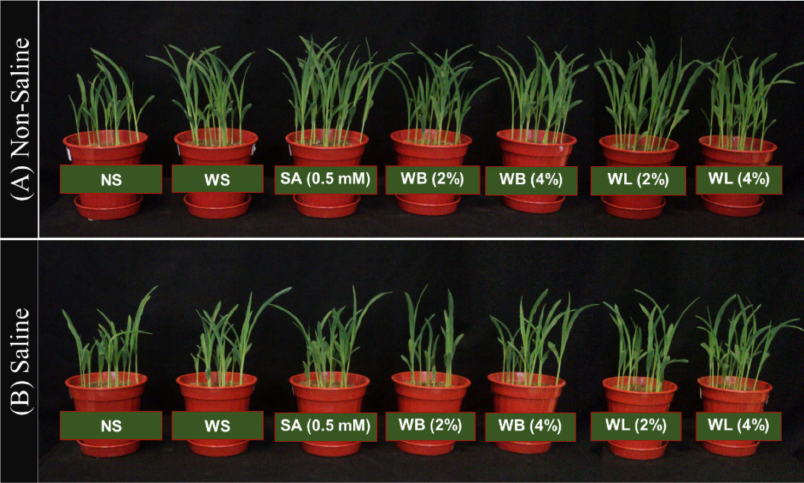
Table 3. Significance of the effects of seed treatments (A), salinity stress (B) and their interactions on reported traits of soil-grown maize ( Zea mays cv. Caramelo) seedlings according to two-way analysis of variance (ANOVA) ( α = 0.05). Source of Variation DF 1 Shoot DW Na P K Seed Treatment (A) 6 n.s. 2 Salinity (B) Source of Variation Seed Treatment (A) Salinity (B)